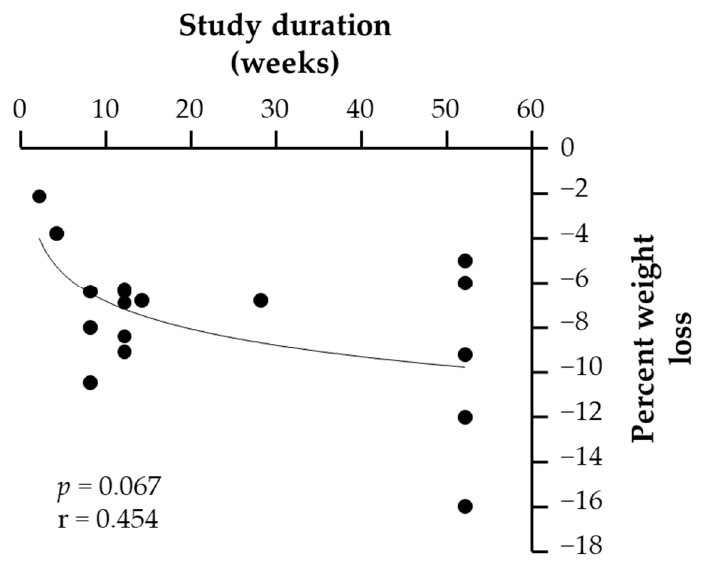
Figure 2. Percent weight loss achieved and duration of dietary intervention. Legend: Each data point represents each study included in the analysis. Two studies were excluded because they did not report percent weight loss / were not able to make calculations because of missing baseline body weight. A quadratic regression analysis was performed to test the relationship between study du- ration and percent weight loss achieved.